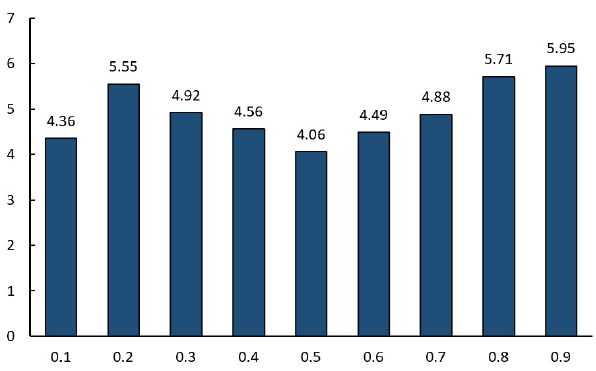
Figure 5. Performance ranking of HV with different ε values.